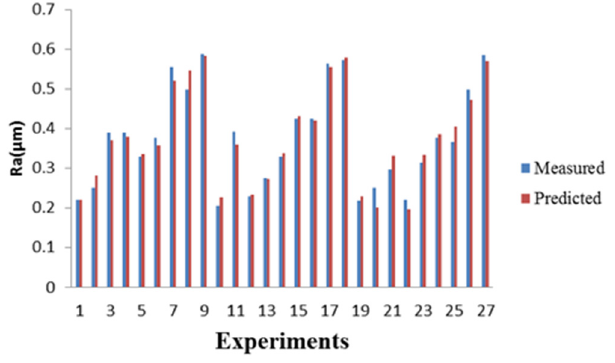
Figure 6. The difference between predicted and measured values of Ra .